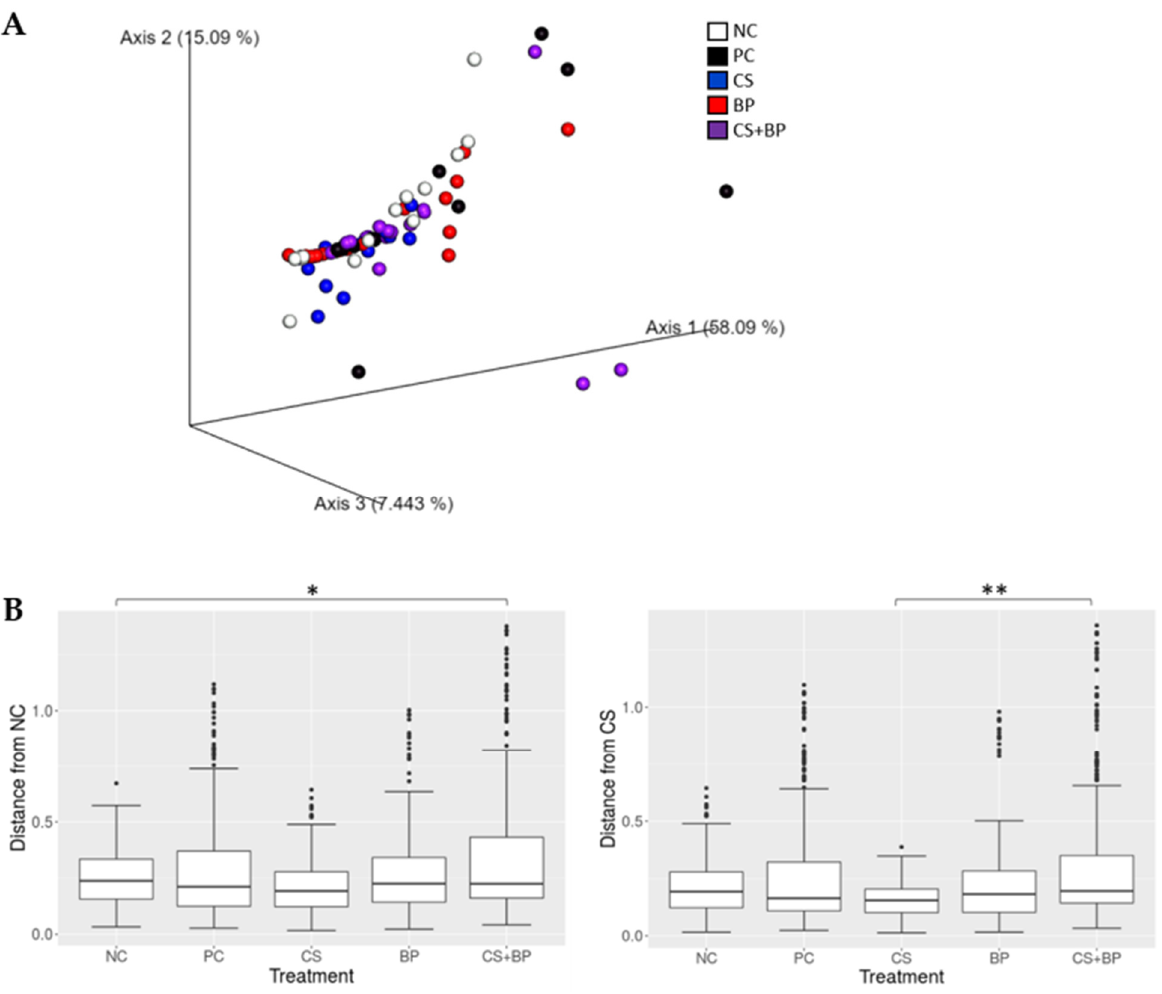
Figure 5. Beta diversity analysis. ( A ) PCoA plot showing beta diversity distances among the 5 treat- ment groups and ( B ) the beta diversity distances in reference to NC and CS group based on weighted UniFrac distance metric. Significant differences at different p- values are indicated by * (<0.05) and ** (<0.01).